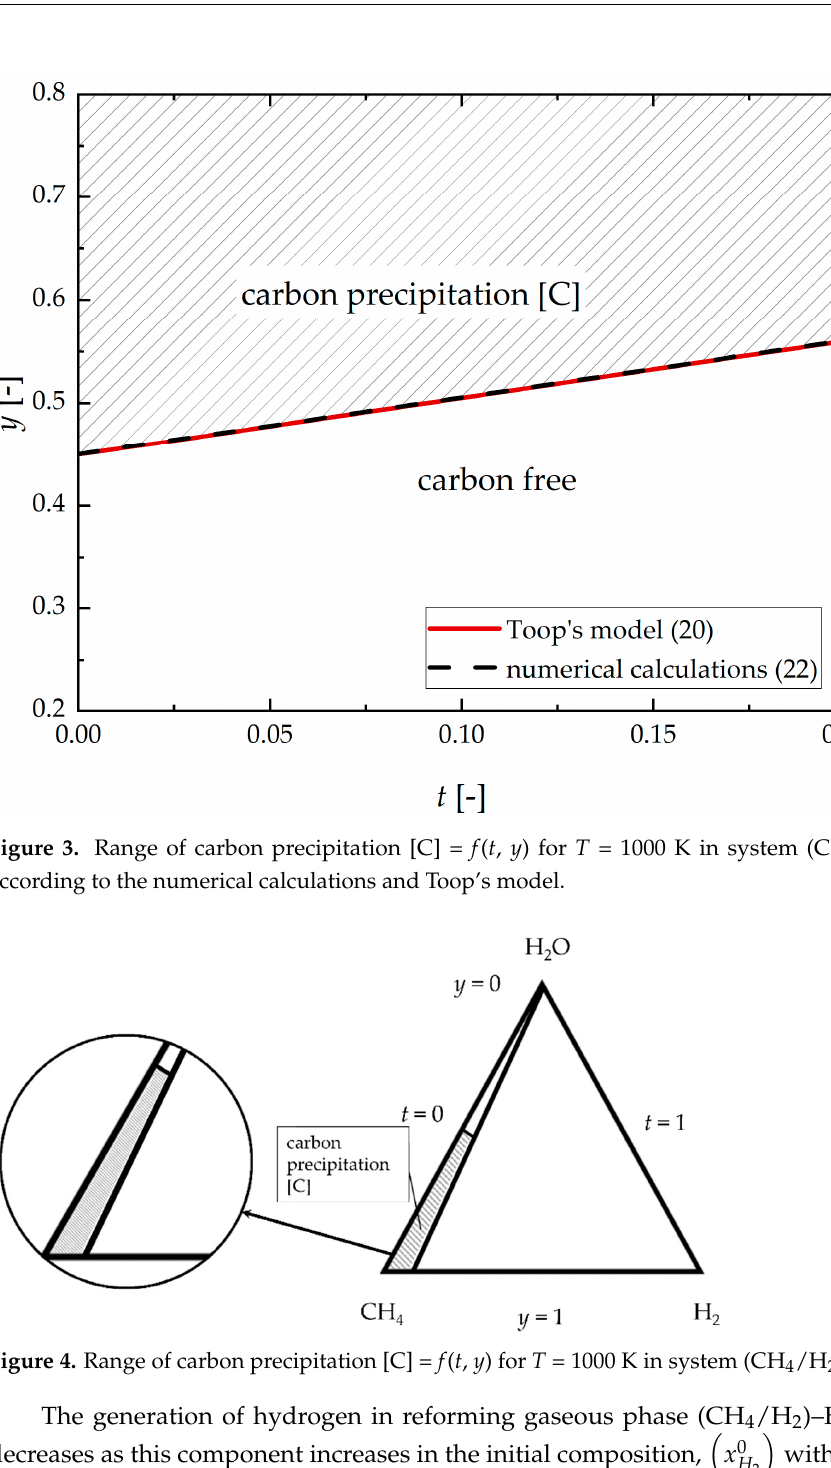
(cid:16) (cid:17) (cid:3016)(cid:2868) . The analysis covered an area x 0 is promotes this phenomenon (Figure 5). By way H 2 O (cid:3009) (cid:3118) (cid:3016)(cid:2868) . The analysis covered an area (cid:3009) (cid:3118) = 0.5629 2 = 0.5290 with t = 0.2. By contrast, for y = 0.5 in an area 2